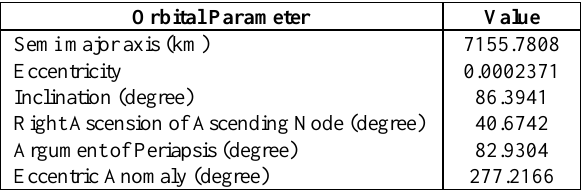
Table 3. TLE parameters of the Iridium satellite